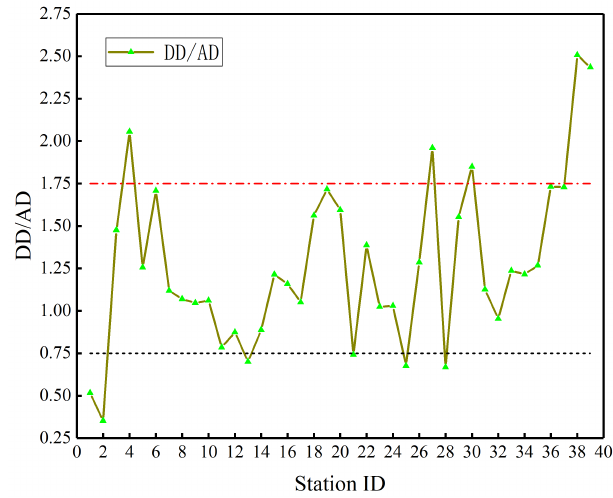
Figure 3. Finally selected image daily-discharge to average discharge ratio, summer flood season at 39 hydrological stations. DD represents daily-discharge, AD stands for average discharge of the summer flood season. The red dotted line indicates that the green triangle on the line has a daily-discharge of 1.75 times AD. The black dotted line indicates that the green triangle on the line has a daily-discharge of 0.75 times